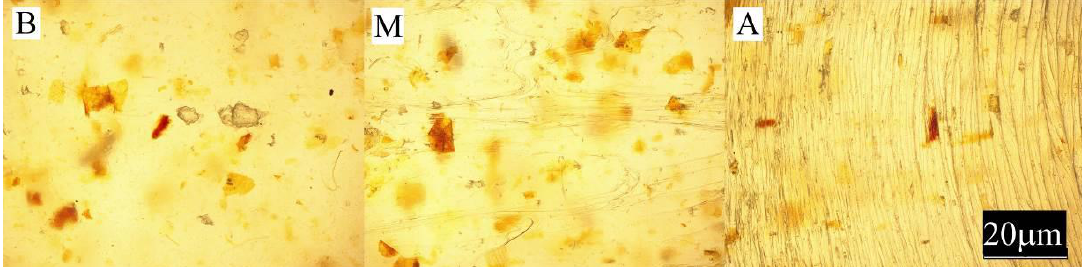
Figure 5. Variability of the gloss of injection mouldings depending on the mass content and grain size of the bran fraction used, on the side of the material supply through the gate — A and on the side opposite to the gate — B.